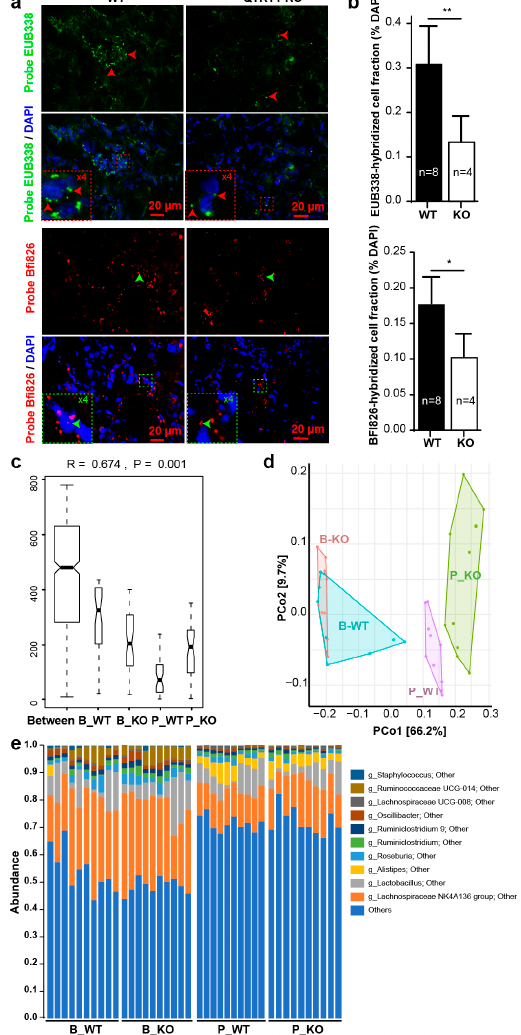
Figure 4. Altered microbiome in tumors and intestines of nude mouse model. ( a ) Fluorescence in situ hybridization [4] staining with DAPI, EUB338, and Bfi826 [20] of the tumors from the nude mice injected with wildtype and QTRT1-KO MCF7 breast cancer cells. Scale bar is 20 µ m. ( b ) Relative bacteria staining was calculated as probe-hybridized cell / DAPI-stained cells. Mean ± SD n = 7 or n = 4; * p -value < 0.05, ** p -value < 0.01, two-tailed Welch’s t -test. ( c ) Plots of between and within means of Bray–Curtis dissimilarity. The analysis of similarity (ANOSIM) was performed on between (Between) and within groups of before QTRT1-KO cell injection (B_KO), before WT cell injection (B_WT), post QTRT1-KO cell injection (P_KO), and post WT cell injection (P_WT) based on the Bray–Curtis dissimilarity analysis. n = 10 per group. ( d ) The principal coordinates analysis (PCoA) plot of the mouse feces was produced to inspect the homogeneity of multivariate dispersions. The samples collected before (B_WT and B_KO) and post (P_WT and P_KO) cell injection were colored in the illustration. n = 10 per group. ( e ) Relative bacterial abundance in species level (g_ indicate genus level; the unidentified species were named with super level and other ) of feces collected from nude mice before (B_WT and B_KO) and post (P_WT and P_KO) injection of wildtype (WT) and QTRT1-KO MCF7 cells was shown with the top 30 species, and lower ones were grouped as “Others”. Species were colored using the key in the list on the right side. Each bar represents individual mice ( n = 10 each